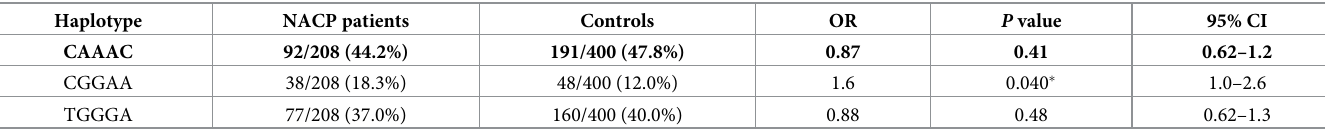
Table 11. Distribution of common PNLIPRP2 haplotype alleles in patients with non-alcoholic chronic pancreatitis (NACP) and in controls. Haplotype